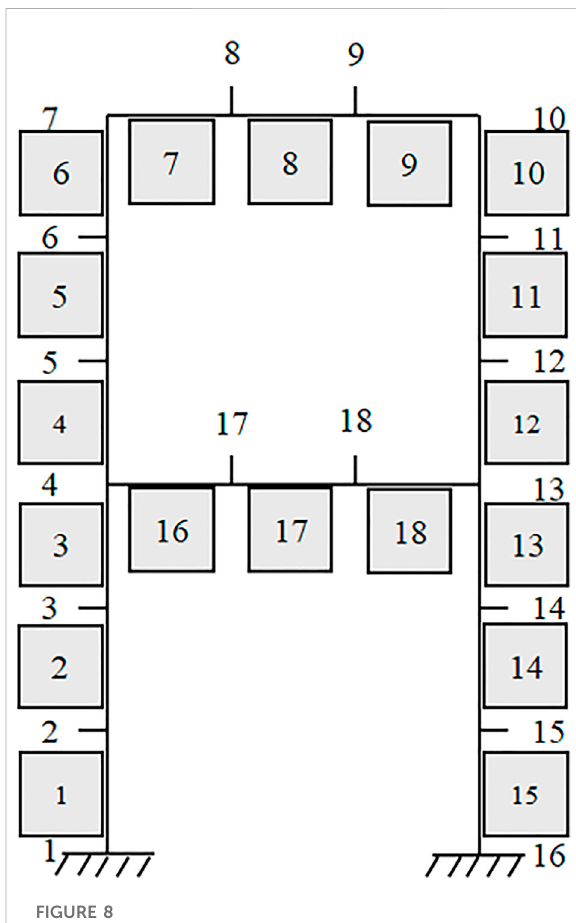
FIGURE 8 Finite element model of two-storey rigid frame